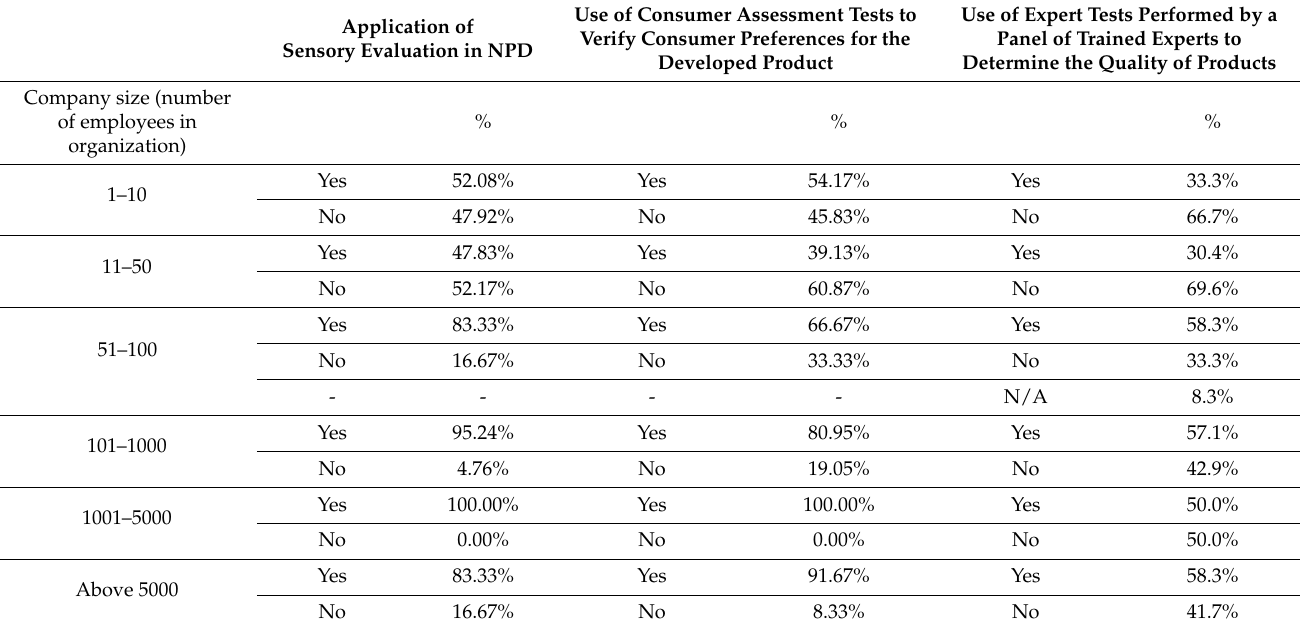
Table 8. Use of sensory evaluation in companies from RIS countries by company